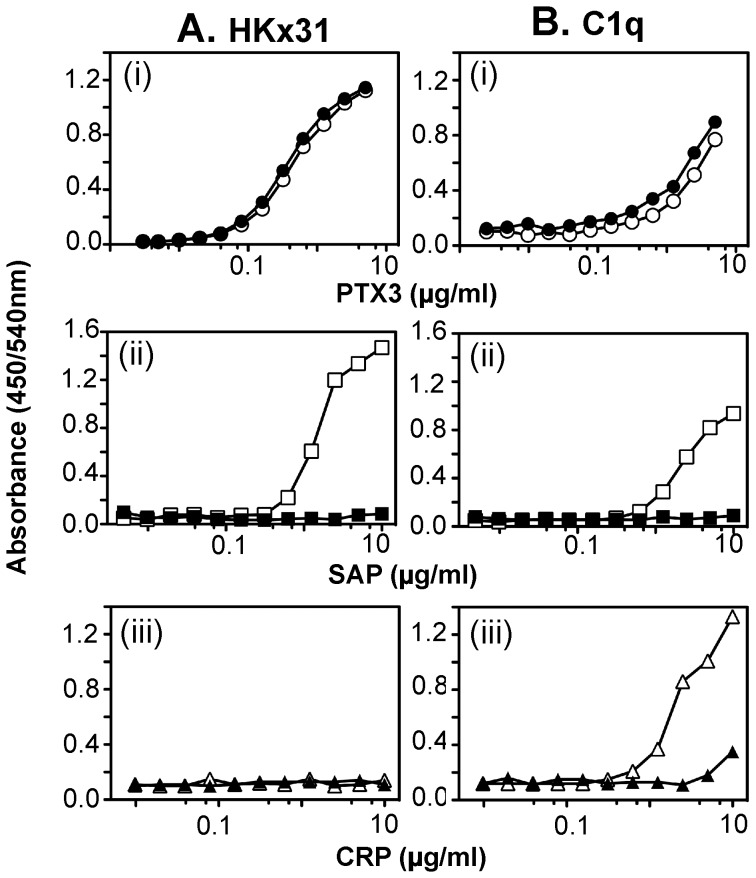
(A/B) Binding of PTX3, SAP and CRP to influenza virus HKx31 and to C1q in presence or absence of calcium.Increasing concentrations of biotin-labelled (i) PTX3 (○,•), (ii) SAP (□,▪) or (iii) CRP (△,▴) in BSA5-TBST supplemented with 10 mM Ca2+ (open symbols) or 5 mM EDTA (closed symbols) were applied to wells coated with (A) 1 µg/ml IAV strain HKx31, or (B) 5 µg/ml C1q and binding determined by ELISA. Data are representative of at least two independent experiments.